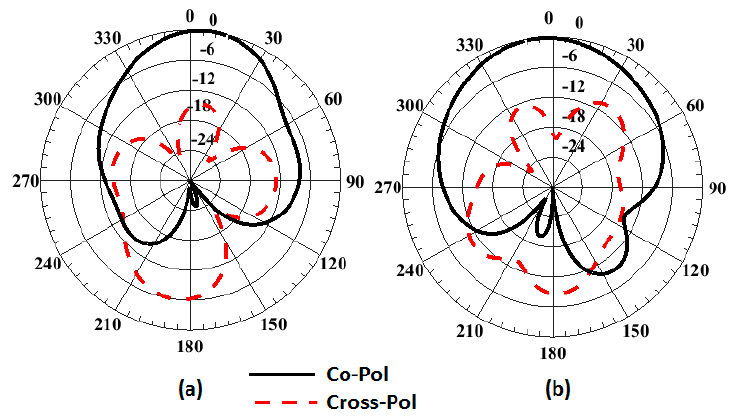
Figure 14. Simulated 3D realized gain of four-port DRA at ( a ) 9 GHz and ( b ) 11 GHz.